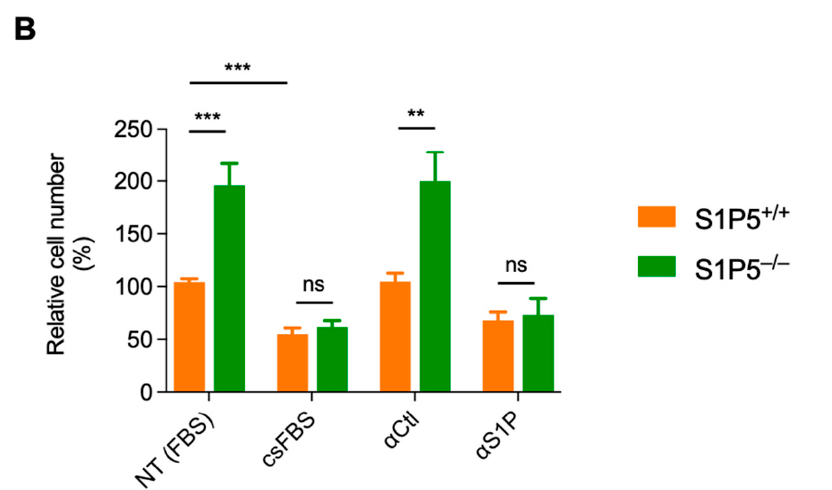
Figure 7. Knockdown of S1P5 promotes cells growth in a S1P dependent manner. ( A ), S1P5 +/+ and S1P5 − / − cells were plated at 20,000 cells/well and 16 h later, cells were treated with vehicle (DMSO), Z-VAD (10 µ M), FTY720-P (1 µ M) or VPC23019 (10 µ M) + JTE-013 (10 µ M). Results show relative cell number expressed as a percentage of control non-treated cells ± SEM from more than three independent experiments performed in triplicates (***, p < 0.0004; ***, p < 0.0007; ***, p < 0.0006; ns, p = 0.8656; **, p < 0.0049; *, p < 0.0240; *, p < 0.0217). ( B ), S1P5 +/+ and S1P5 − / − cells cultured as in ( A ) and were either grown in DMEM containing delipidated FBS (csFBS) or in complete medium containing FBS in the presence of control antibodies ( α -Ctl) or antibodies against S1P ( α -S1P). Cells were counted 48 h post treatment. Results show the relative cell number expressed as a percentage of control non-treated cells ± SEM from three independent experiments performed in triplicate (***, p < 0.0001; ns, p = 0.4685; **, p < 0.0031; ns, p = 0.7922; ***, p <